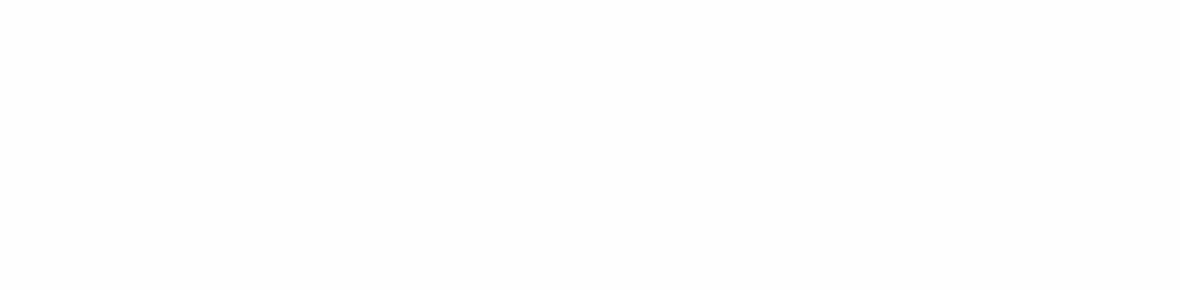
Fig.3: Time profiles of various samples in creep and elastic